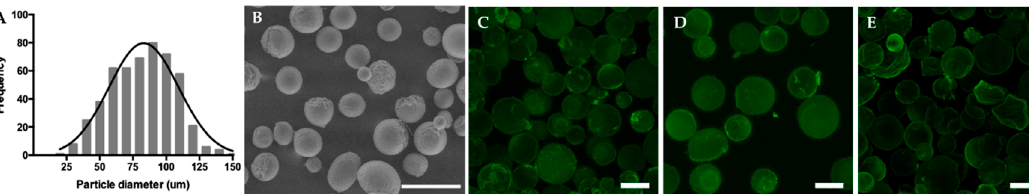
Figure 1. Poly-lactic acid (PLA) Microcarrier production and characterization. ( A ) Particle size distribution histogram. ( B ) PLA microcarrier (MC) SEM image, scale bar = 200 μ m. ( C – E ) Collagen type I (green) staining of the functionalized MCs after 10, 30, and 60 min of 0.5 M NaOH hydrolysis, scale bars = 50 μ m.